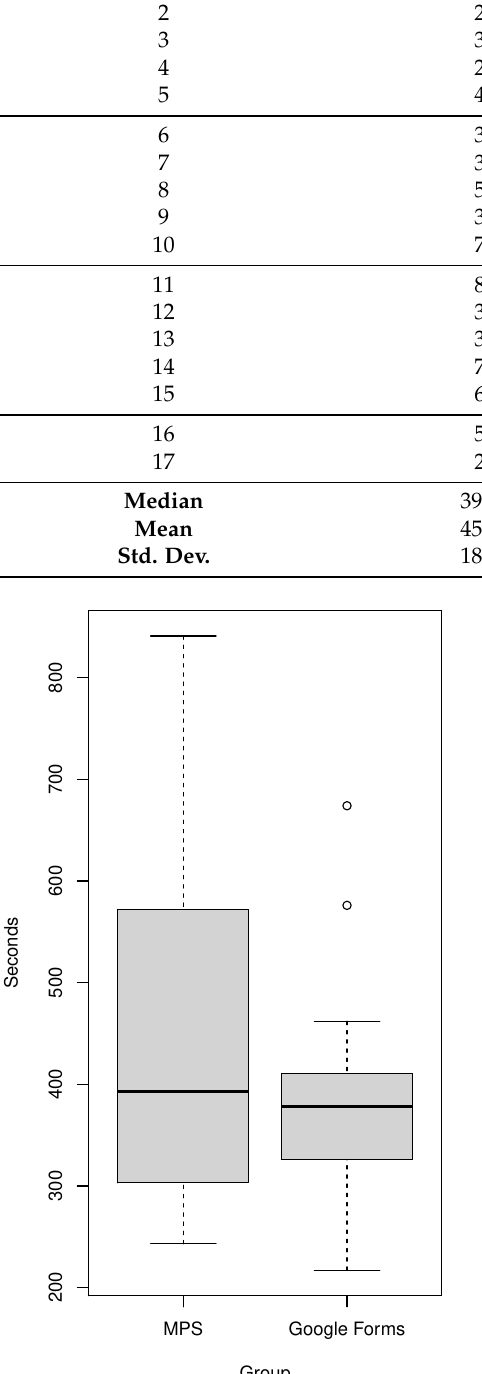
Figure 6. Results of the MPS vs. Google Forms